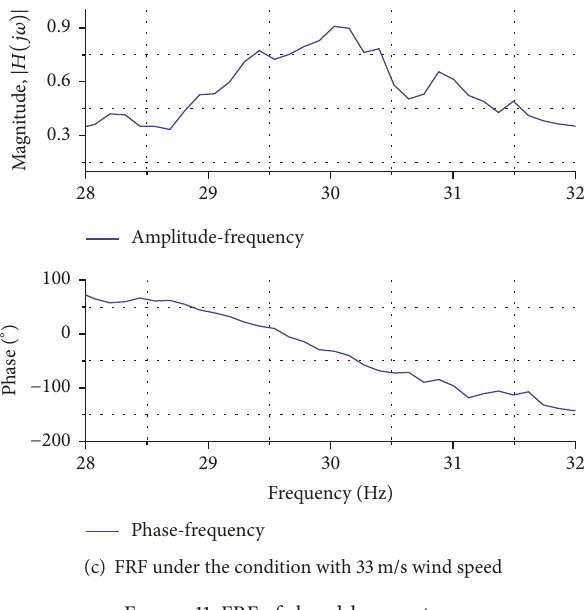
Figure 11: FRF of closed-loop